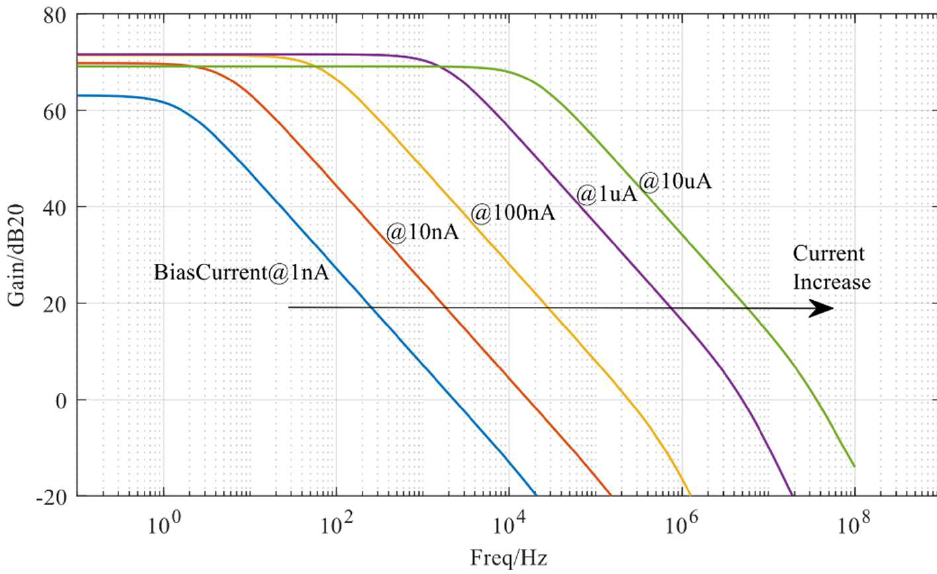
Figure 7. Dynamically increasing the closed-loop bandwidth.